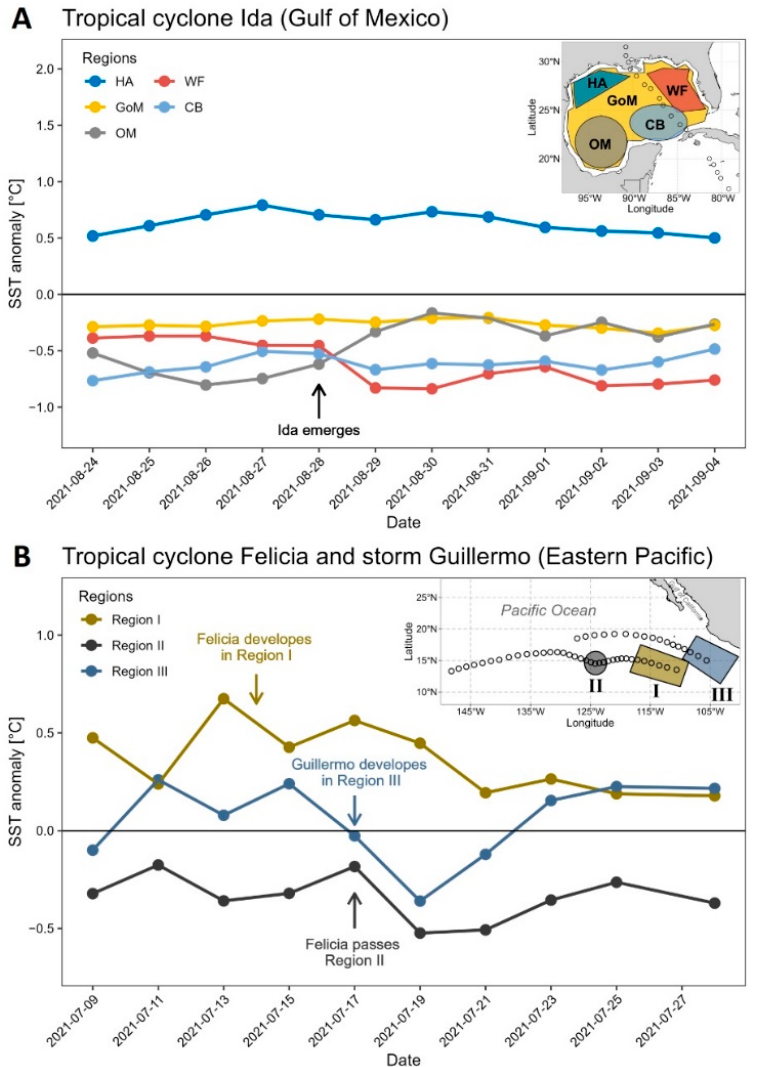
Figure 1. Anomalies in SST related to Ida ( A ) and Felicia and Guillermo ( B ) for the respective regions of interest. Days when the storm develops or passes are indicated by arrows and described in the panels.